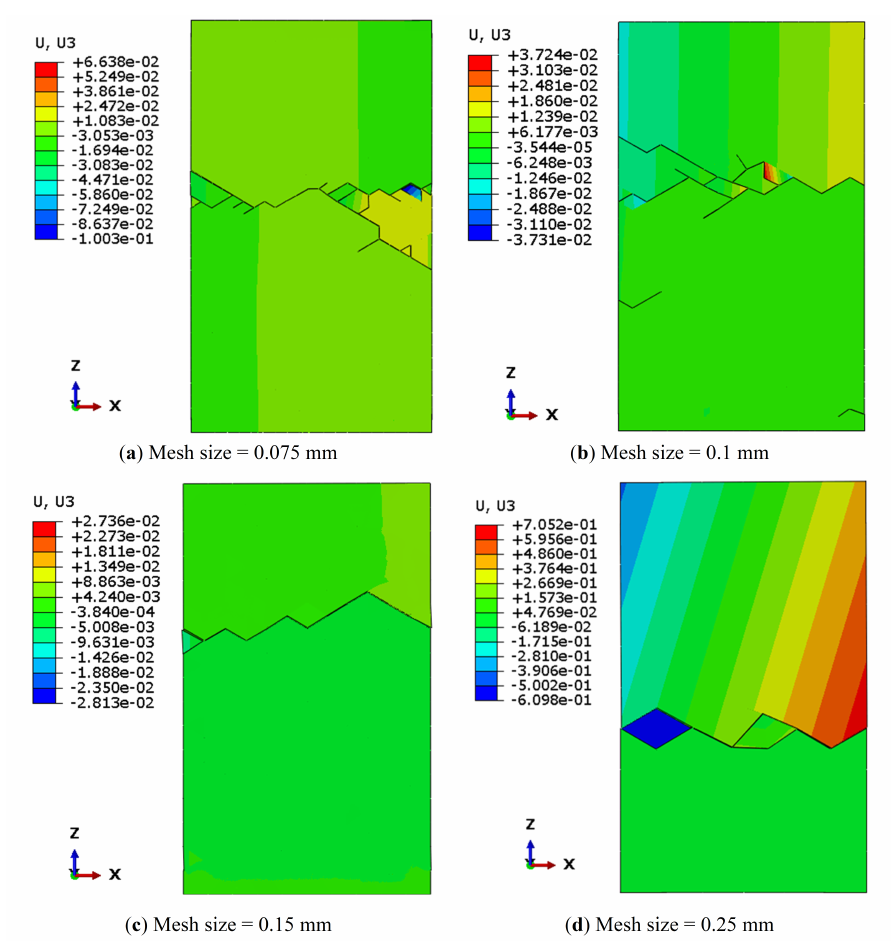
Figure 4. The failure pattern of the samples with different mesh sizes. The legends in the figure correspond to the displacement of the samples in the z-direction (U 3 ). It is observed that a horizontal crack perpendicular to the loading direction is generated during the loading process. The single main crack causes catastrophic failure. In some cases, the main crack may split into multiple